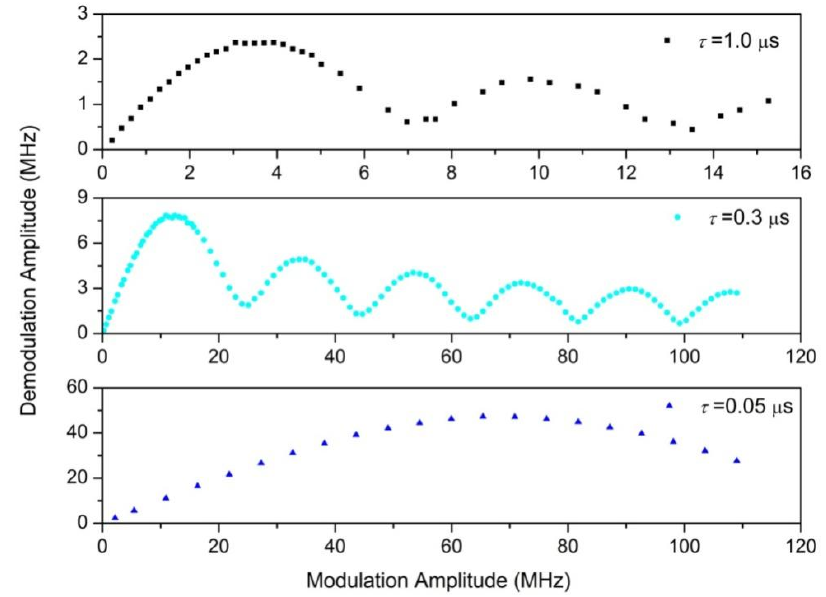
Figure 2. The demodulation frequency amplitude ν d with respect to the modulation amplitude ν m at different delay times of 0.05 μs, 0.30 μs, and 1.00 μs, respectively.